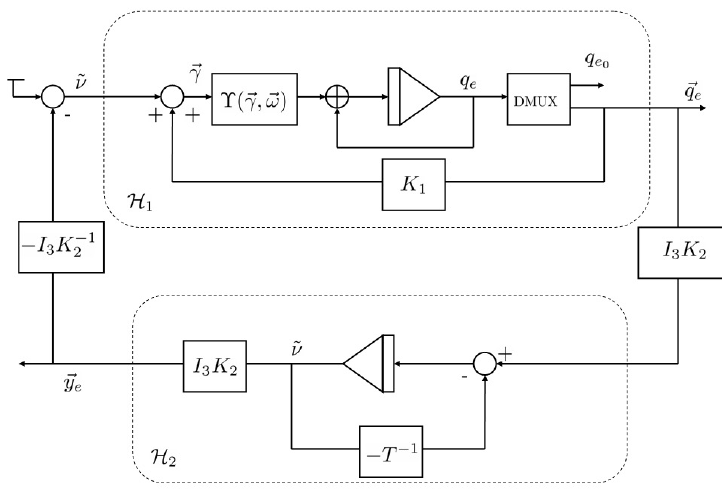
Figure 2. Block diagram of the dynamics of attitude and bias